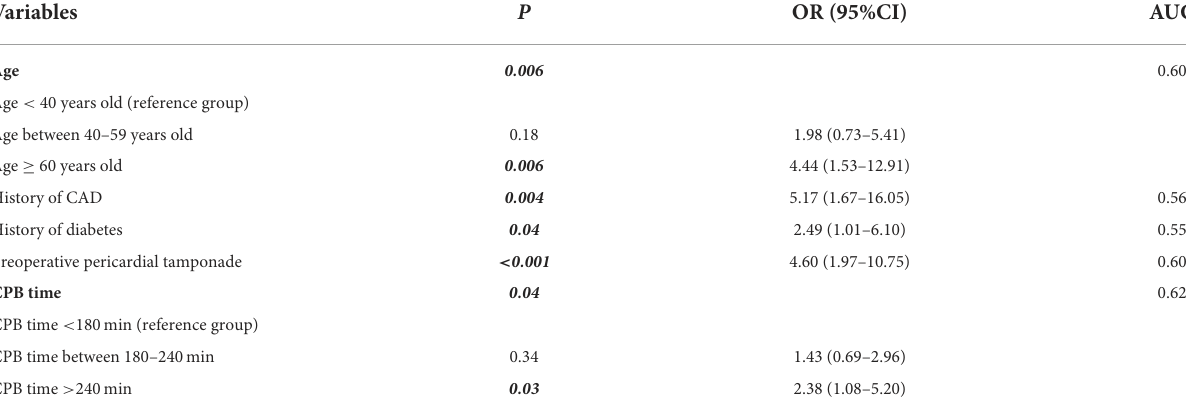
TABLE 5 The results of univariate logistic regression analysis showing the risk factors of EF reduction in patients with AKI undergoing CRRT after ATAAD surgery.